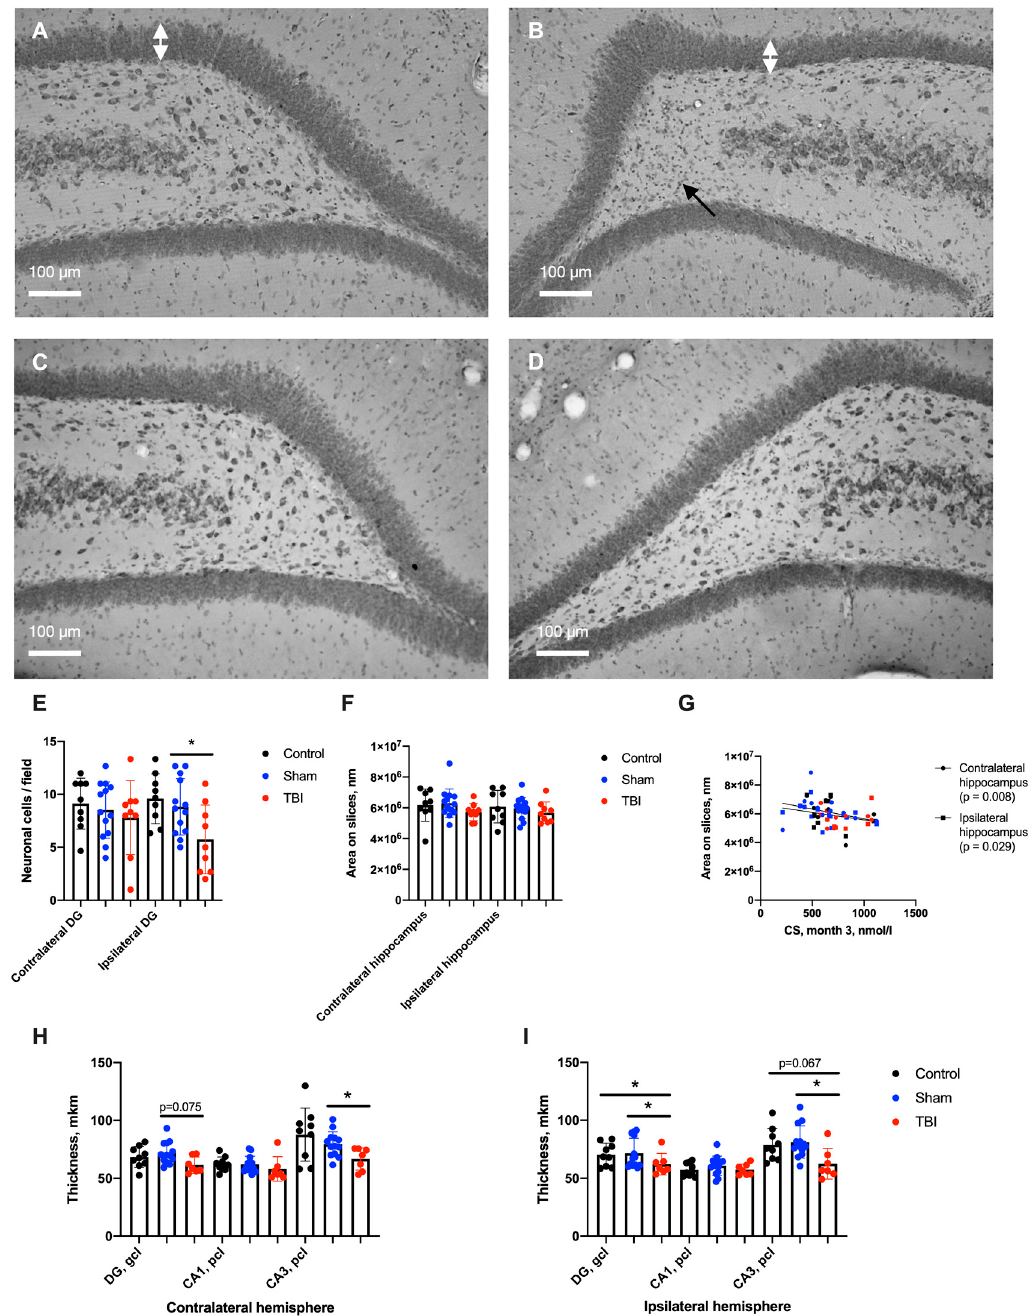
Figure 4. Neurodegeneration in the hippocampus 3 months after TBI. ( A , B )—Contralateral and ipsilateral hippocampal DGs of rats after TBI, respectively; Nissl staining. White arrows show granular cell layer (gcl) thicknesses, and black arrows show areas of neuronal cell loss in the polymorph layer. ( C , D )—Contralateral and ipsilateral hippocampal DGs of Sham rats, respectively; Nissl staining. ( E )—Neuronal cell density in the hippocampus. The number of neurons was lower in the ipsilateral DG. ( F )—Hippocampal area on slices. ( G )—Correlation between hippocampal areas on slices and CS levels 3 months after TBI (Spearman correlation). ( H , I )—Thickness of hippocampal cell layers in contralateral and ipsilateral hemispheres, respectively. Thinning of cell layers was observed in the granular cells layer (gcl) and pyramidal cells layer (pcl) in the CA3 of both hemispheres. *— p < 0.05, Kruskal–Wallis test with post-hoc Dwass–Steel–Critchlow–Fligner test.